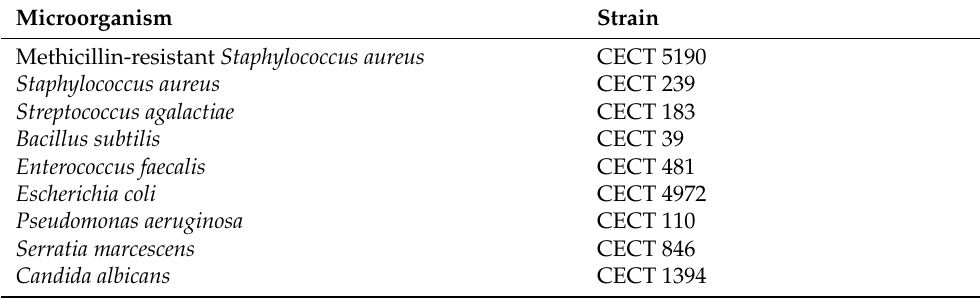
Table 6. Microorganisms used in the antimicrobial activity